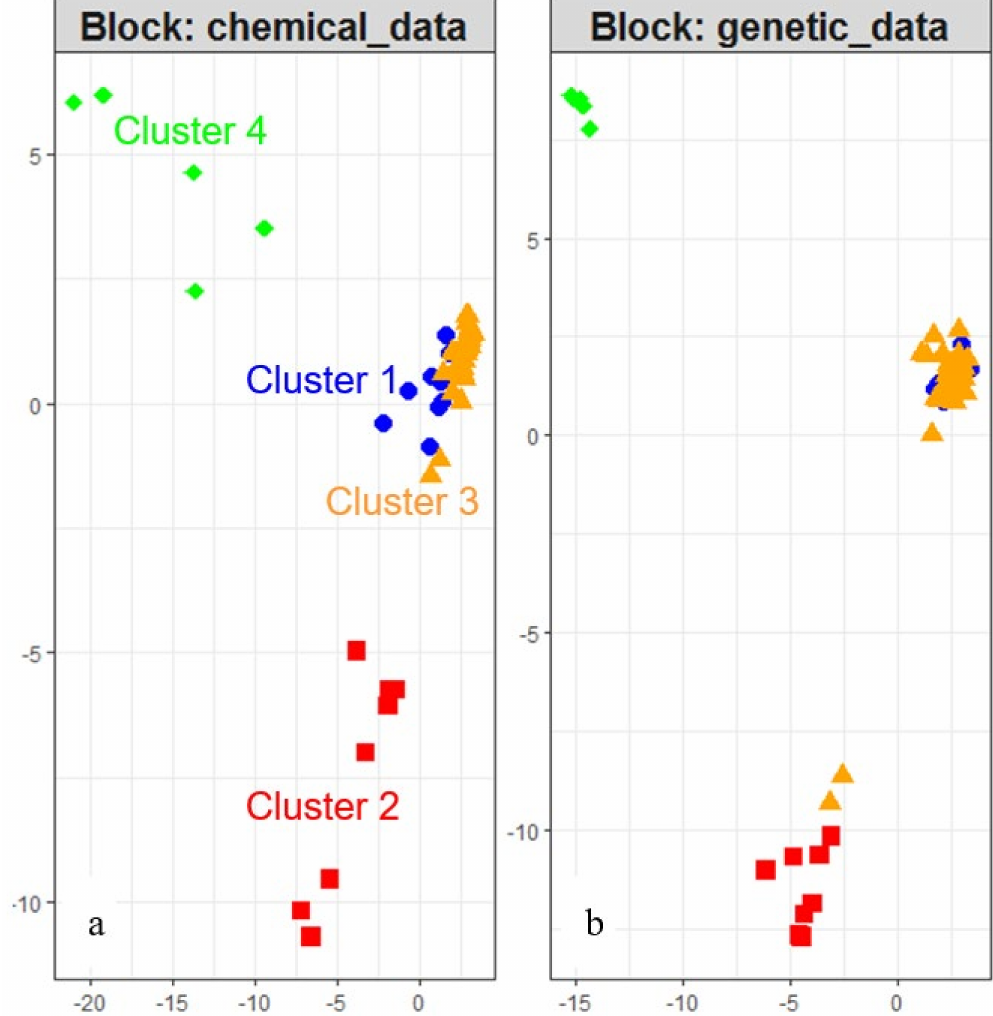
Figure 2. Congruency of the structures of individuals between chemical ( a ) and genetic dataset ( b ), resulting from DIABLO (data integration analysis for biomarker discovery using latent variable approaches for omics studies) analysis. Each point represents one individual placed according to its projection in the subspace defined by the latent variables of the multivariate model (N total = 90; N cluster1 = 12; N cluster2 = 8; N cluster3 = 65; N cluster4 = 5). This plot enables to visualize similarities between samples. The four di ff erent symbols materialized the 4 chemotypes identified by DAPC on 90 individuals of 14 wild sampled sites of lavender and 5 cultivated